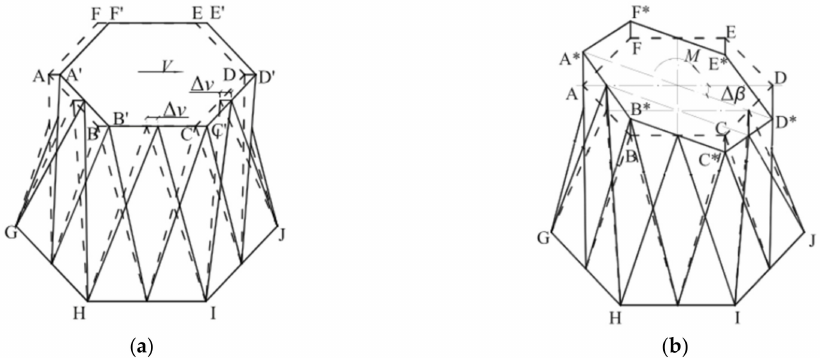
Figure 6. Scheme for the calculation of ( a ) shear rigidity; ( b ) bending rigidity, according to the modular method (MM). Used with permission from Liu and Ma